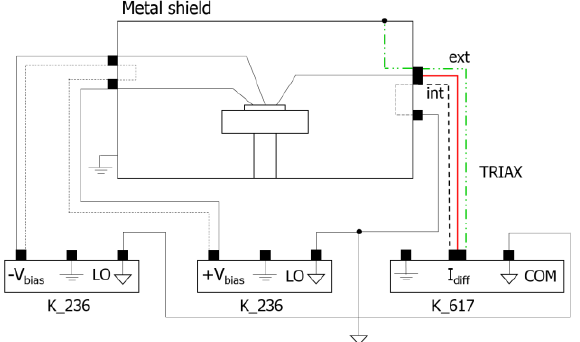
Figure 5. Scheme of the setup used for the measurement of the differential current. The metal box minimizes the electromagnetic noise.